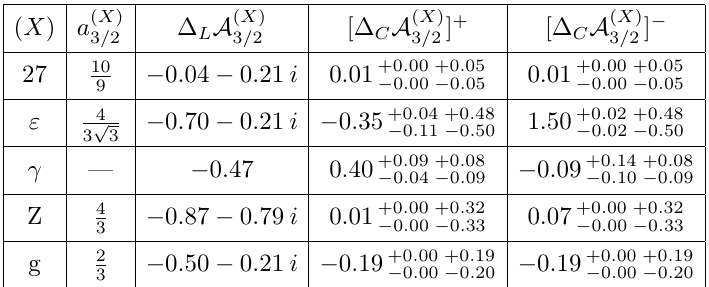
. The two uncertainties in the local 3 = 2